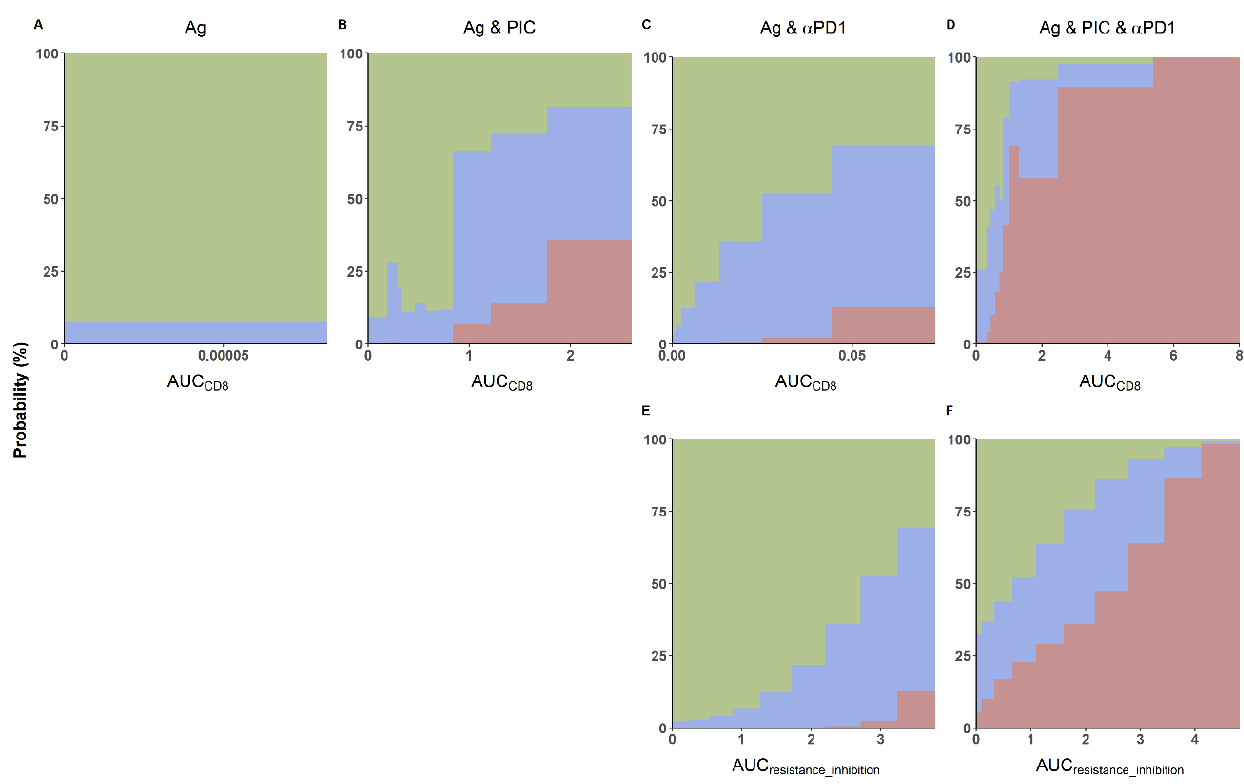
Figure 6. Effect of the area under the levels of activated CD8 (A – D) and resistance inhibition induced by αPD1 (E,F) vs. time curve (AUC CD8 and AUC resistance_inhibition , respectively) on response rates expressed as a percentage of mice showing total response (red), transient response (blue), and absence of response (green). One thousand animals for each of the 100 different parameter combinations were simulated for the multiple treatment groups: (A) Ag, (B) Ag and PIC, (C,E) Ag and αPD1 , and (D,F) triple-therapy.